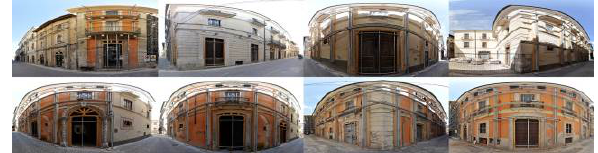
Figure 6. Equirectangulars images arising from spherical panoramas of the exterior of the city block.